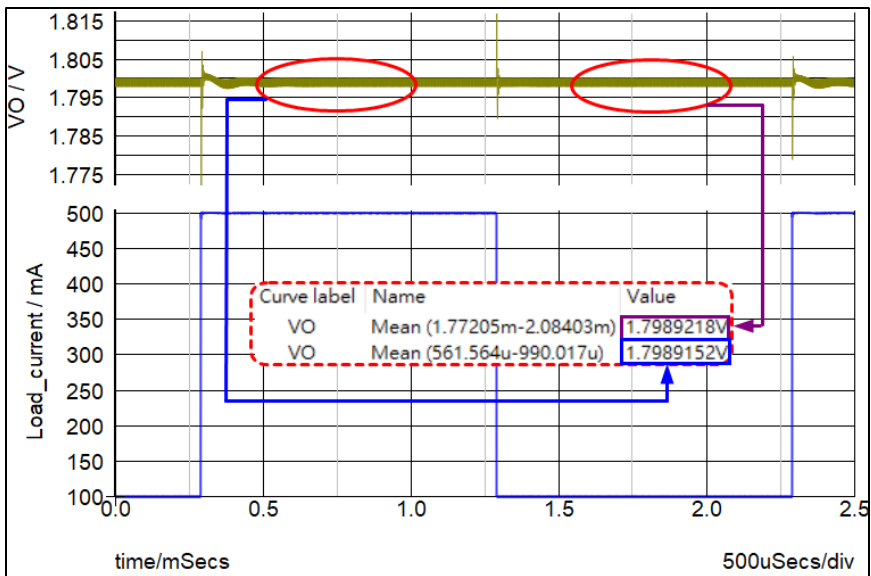
Figure 9. Load regulation.